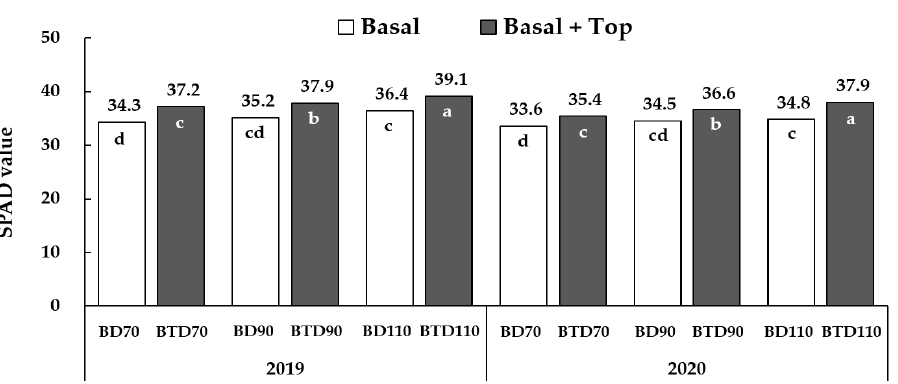
Figure 2. Variation in SPAD value according to nitrogen application methods. Means with the same letters in 2019 and 2020 are not significantly different at 5% level as determined by Duncan’s multiple range test. Table 4. Grain-related traits according to nitrogen application